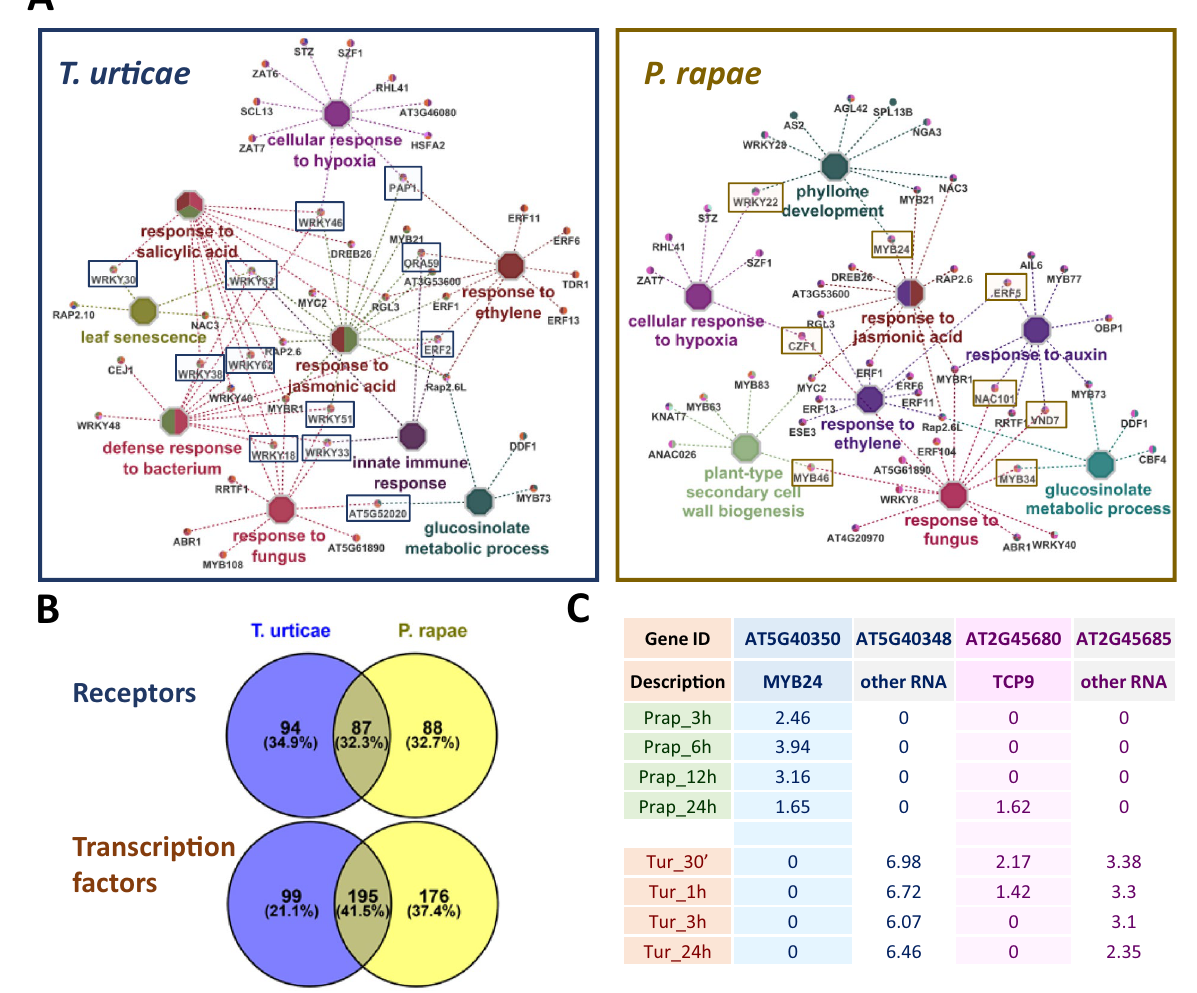
Figure 4. Comparison of putative receptors and TFs differentially regulated in response to P. rapae or T. urticae . ( A ) Networks showing the String-based interactions after five rounds of adding nodes to the initial TFs detected in the defense-related categories and distinctive of the Arabidopsis response to T. urticae and P. rapae (boxed). ( B ) Venn diagrams showing the number of specific and shared regulated receptors and TFs. ( C ) Table showing the expression of two TFs regulated by